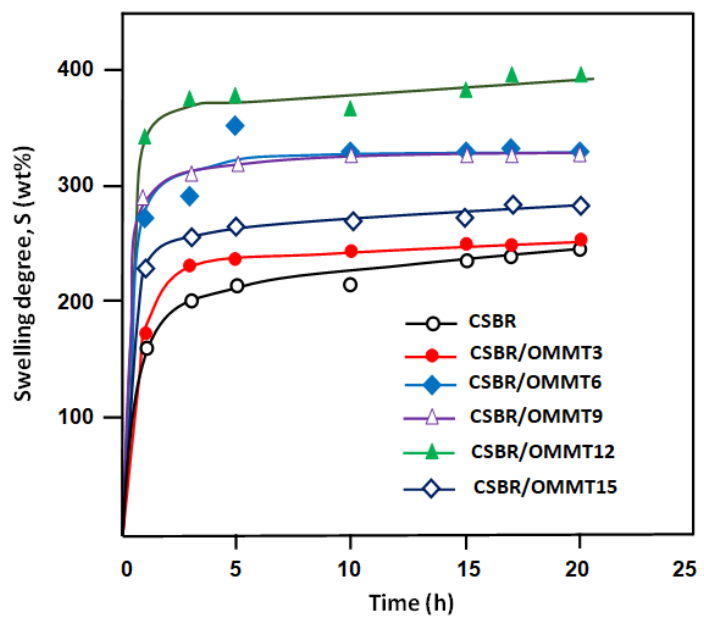
Figure 8. Variation of the swelling degree of CSBR and CSBR/OMMT membranes with different OMMT contents versus time in toluene.